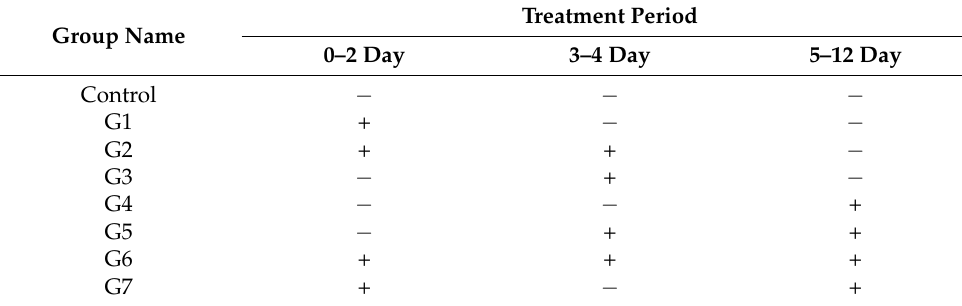
Table 1. SB431542 treatment